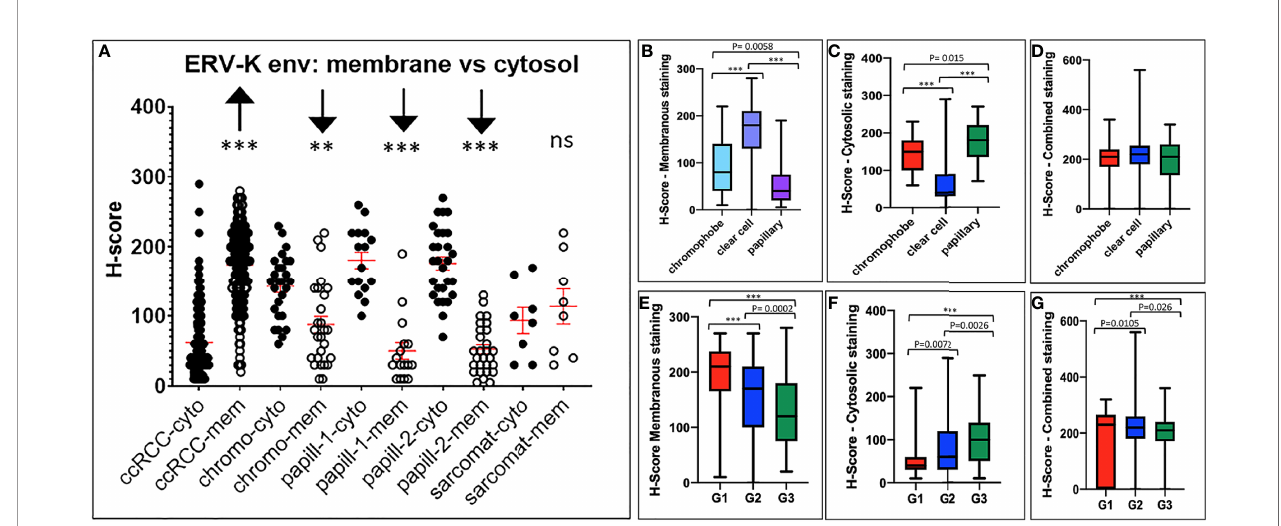
FIGURE 3 | ERV-K env protein localization and clinical correlations between RCC tumor subtypes. (A) ERV-K env cytosolic (cyto) or membrane (mem) localization represented as H-scores (Y-axis; 0 - 400) for each RCC tumor TMA subtype (X-axis). TMA; ccRCC = clear cell carcinoma (n= 288) with sarcomatoid (Sarcomat) features (n= 8); Chromo = chromophobe (n= 27); papill-1 and -2 = Papillary 1 (n= 18) and 2 (n= 27). ***p< 0.0001; **p= 0.0003, ns = not signi fi cant. Red bar crosses represent the mean for each cohort tumor subtype. (B) Bar graphs comparing ERV-K env membranous or (C) cytosolic staining or (D) total protein expression (combined) with the H-score signi fi cance and RCC tumor subtypes. (E) Bar graphs comparing ERV-K env membranous or (F) cytosolic or (G) total protein expression (combined) for each RCC tumor subtype staining with the H-score signi fi cance comparing RCC tumor subtypes and tumor grading (G1, G2, G3). All p-values are indicated within the graphs or ***p<